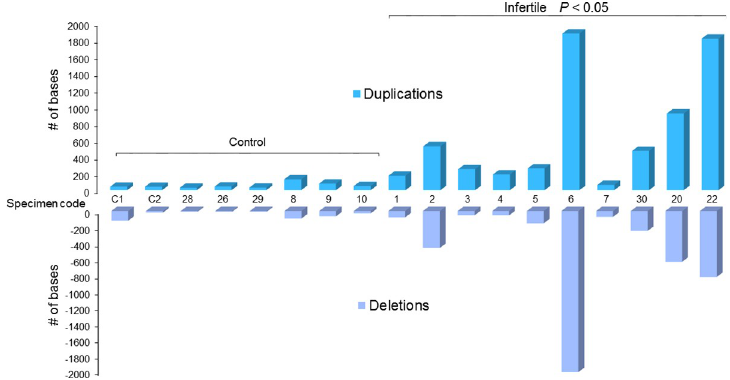
Fig 7. Histogram graph displaying overall gene mutations observed by CNV analysis in the study population. Each bar indicates a specimen. The gene duplications (dark blue histogram) and gene deletions (light blue histogram) are higher in the infertile cohort in comparison to the fertile control group ( P < 0.05).